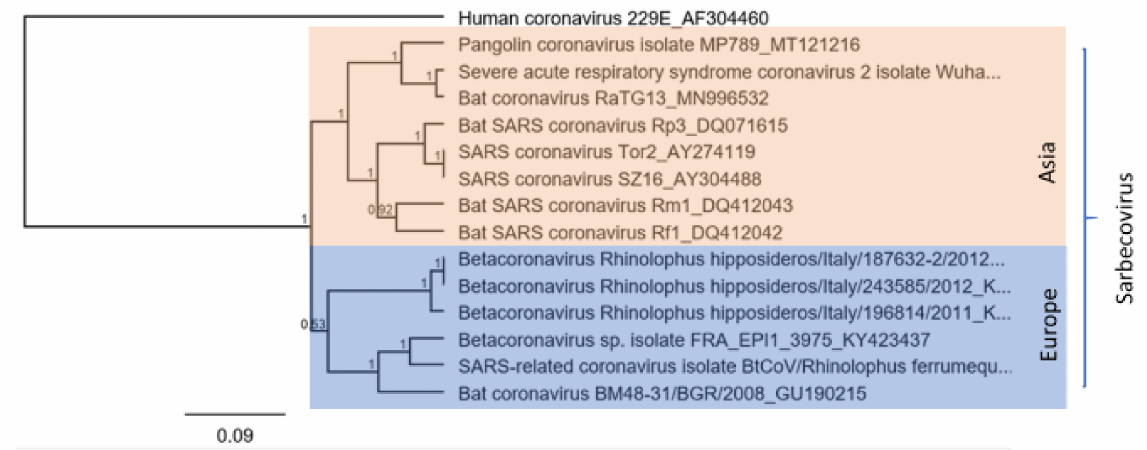
Figure 6. Phylogenetic reconstruction of European SARS-like Betacoronaviruses with SARS-like viruses and SARS-CoV viruses from Asia. Phylogenetic reconstruction was calculated based on a 392 nt long fragment of CoV available under the accession numbers mentioned in the tree. Calculations were performed using Clustal, MrBayes (GTR, 10 Mio, 10 percent Burn-in), visualization Geneious